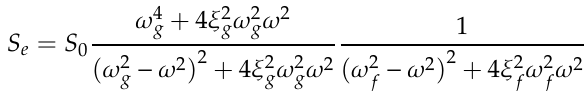
Table 7 listed the error ratio of several concerned